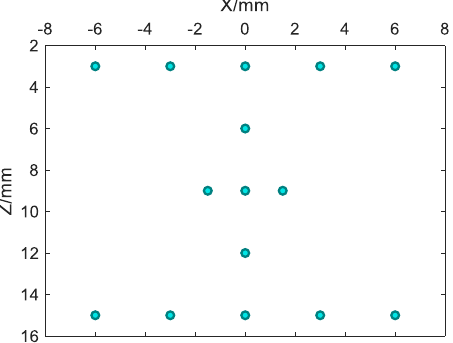
Figure 8. Point targets space position.